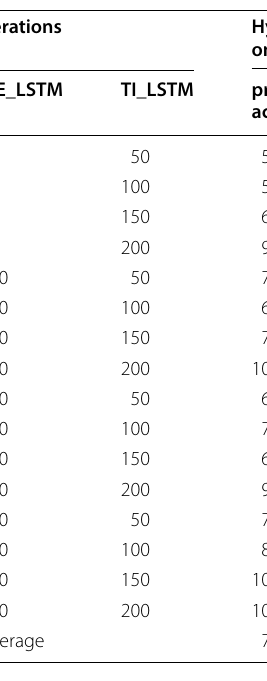
Hybrid model‑modification based on TI_LSTM